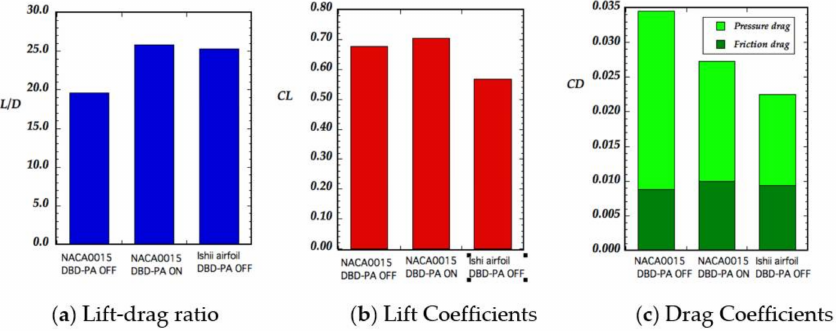
Figure 13. Aerodynamic Coefficients of NACA0015 with and without DBD plasma actuator compared with Ishii airfoil. NACA0015 ( α = 6 ◦ ), Ishii airfoil ( α = 4 ◦ ), Re = 6.3 × 10 4 , F + = 6.0, Dc = 0.05, BR = 10%.